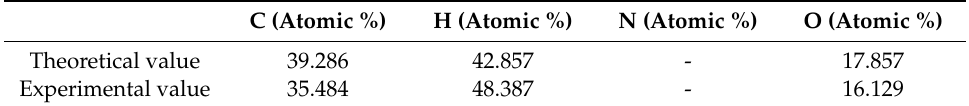
Table 1. Elemental analysis of FEEMA